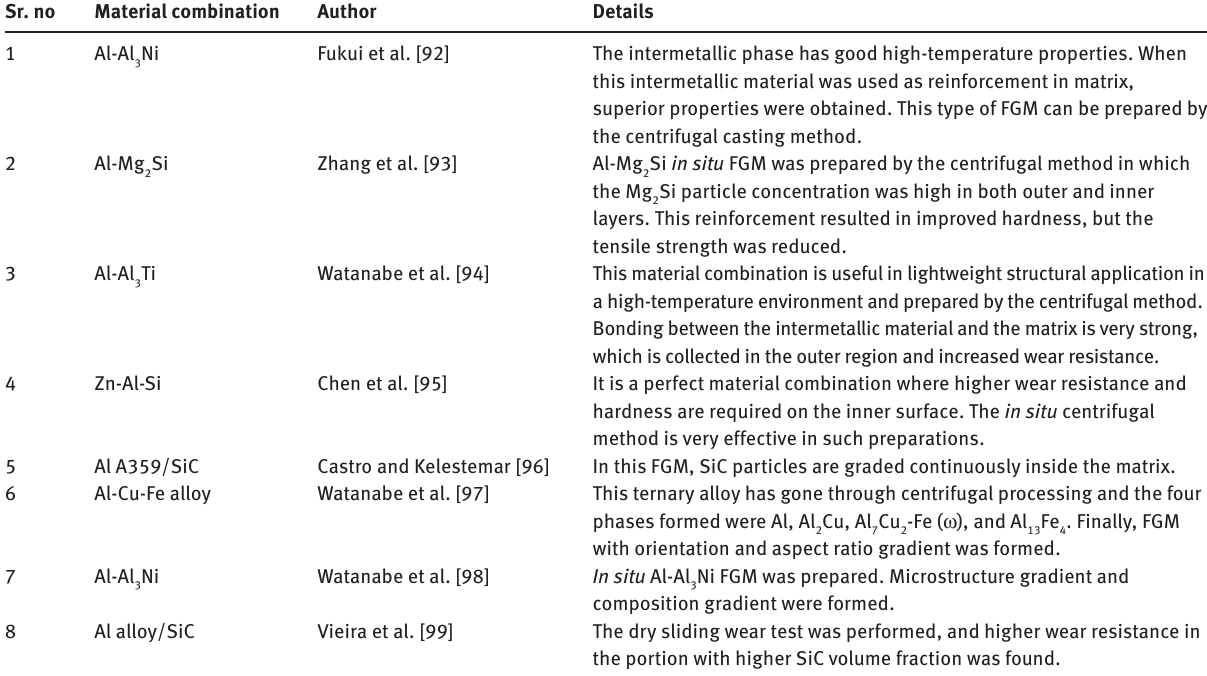
Table 8: List of different authors who used centrifugal casting for fabrication of